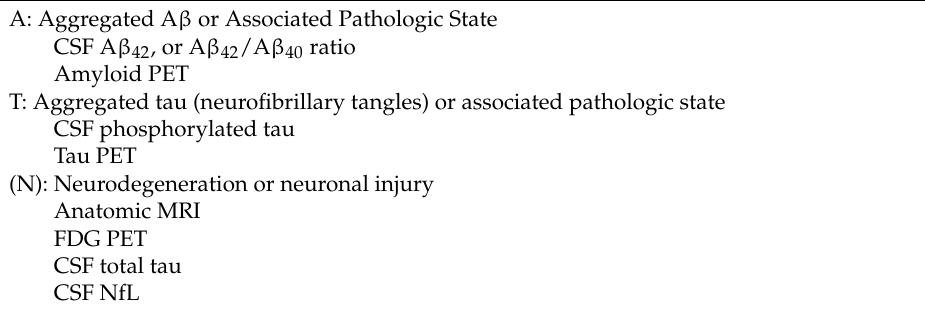
Table 2. NIA-AA biomarker grouping scheme (adapted from Jack et al. [26]). A: Aggregated A β or Associated Pathologic